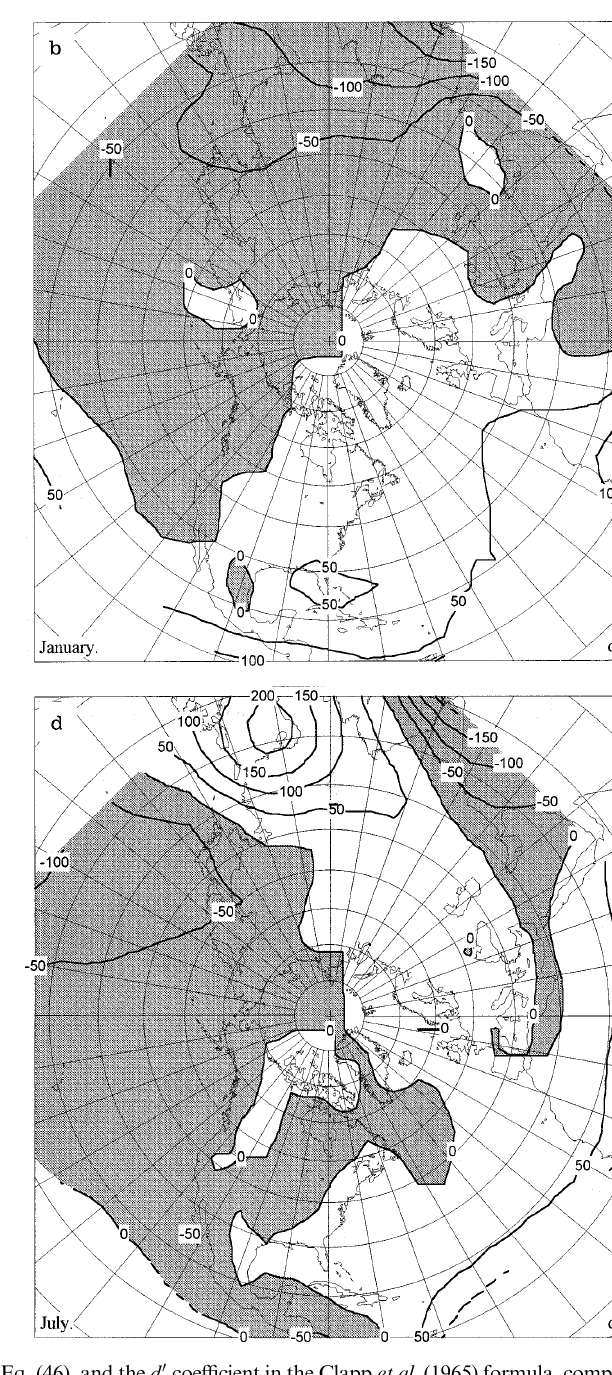
Fig. 4a–d. Geographical patterns of the d 00 coe(cid:129)cient in the theoretical Eq. (46), and the d 0 coe(cid:129)cient in the Clapp et al. (1965) formula, computed in 2 Wm (cid:255) 2 K (cid:255) 1 . a Is the d 00 coe(cid:129)cient for winter, b the d 0 coe(cid:129)cient for winter, c the d 00 coe(cid:129)cient for summer, and d the d 0 coe(cid:129)cient for